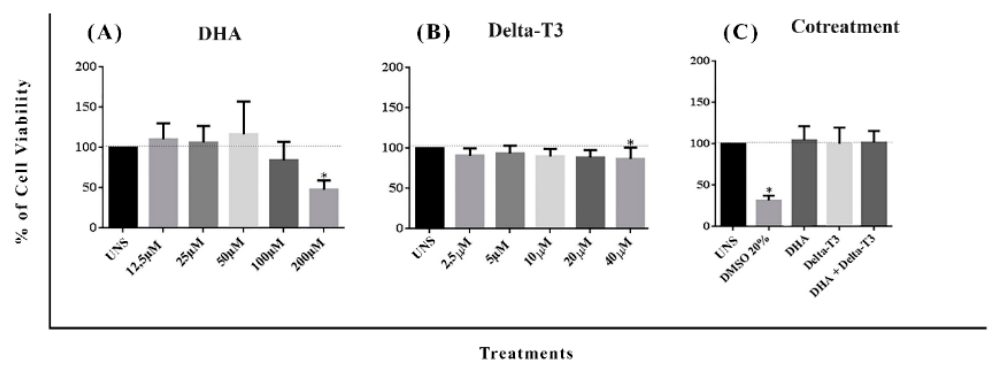
Figure 2. ( A ). Cytotoxicity of DHA at concentrations of 12.5 μ M, 25 μ M, 50 μ M, 100 μ M and 200 μ M. ( B ). Cytotoxicity of delta-tocotrienol (Delta-T3) at concentrations of 2.5 μ M, 5 μ M, 10 μ M, 20 μ M and 40 μ M. ( C ). Cytotoxicity of DHA (50 μ M) plus Delta T3 (5 μ M) co-treatment. All MDA-MB-231 cells were treated for 24 h and cytotoxicity was measured by MTT ( n = 5). Values were expressed as mean ± SD. Results considered statistical had p < 0.05 (*) compared to unstimulated MDA-MB-231 cells (UNS).